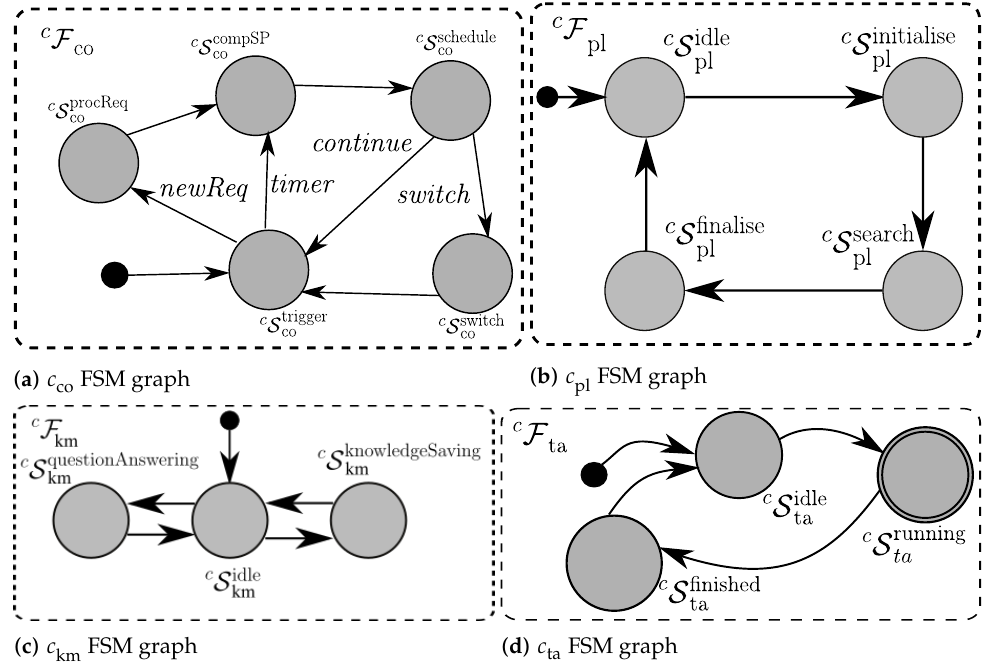
Figure 11. FSMs governing the behaviours of the agents, i.e. their control subsystems. The arc labels specify conditions; missing labels are always True . The conditions are checked as soon as a behaviour terminates. Table 3. Mapping of the states of c co FSM to a co behaviours